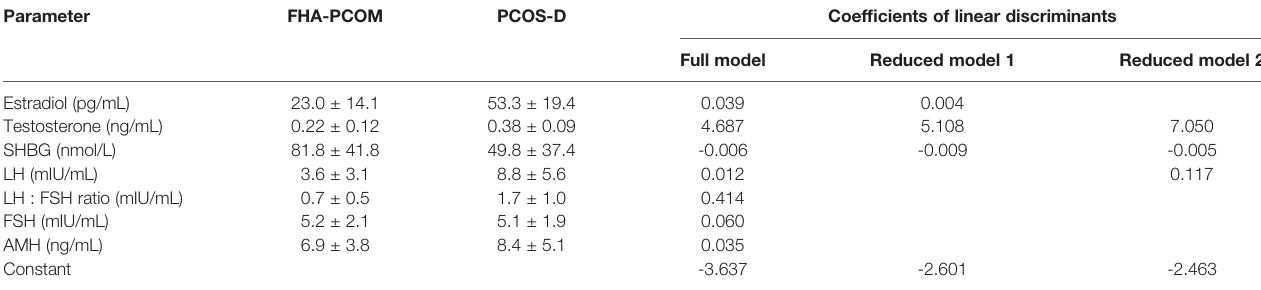
TABLE 3 | Results of the linear discriminant analyses.